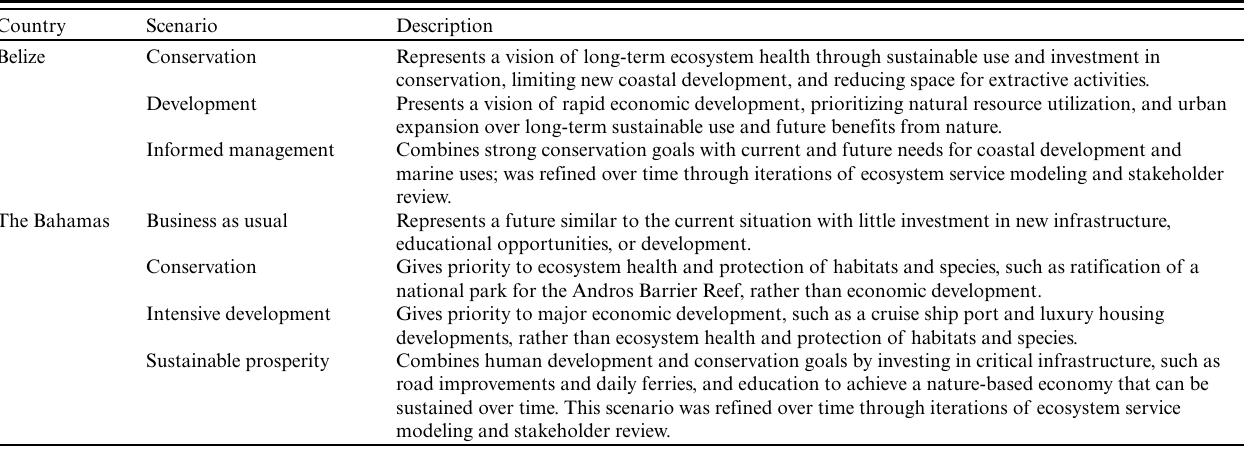
Table 1 . Description of stakeholder-driven development scenarios for integrated coastal zone management in Belize and sustainable development of Andros Island in The